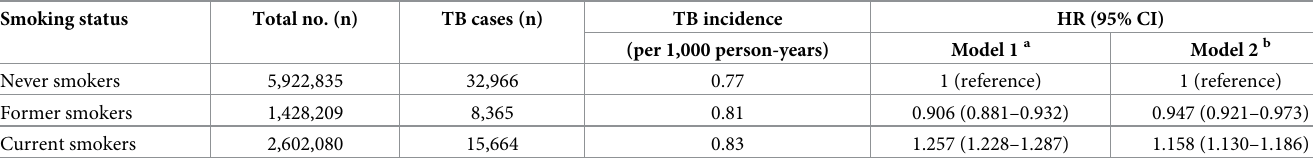
Table 2. Incidence and risk of tuberculosis according to smoking status.